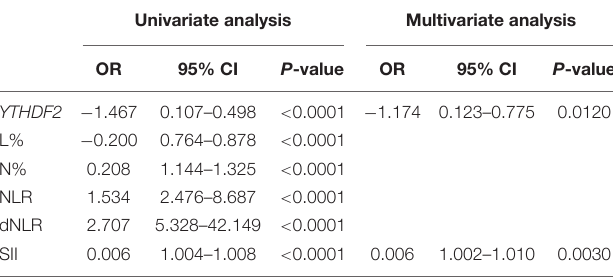
TABLE 5 | Univariable and multivariable analysis of risk factors correlated with new-onset